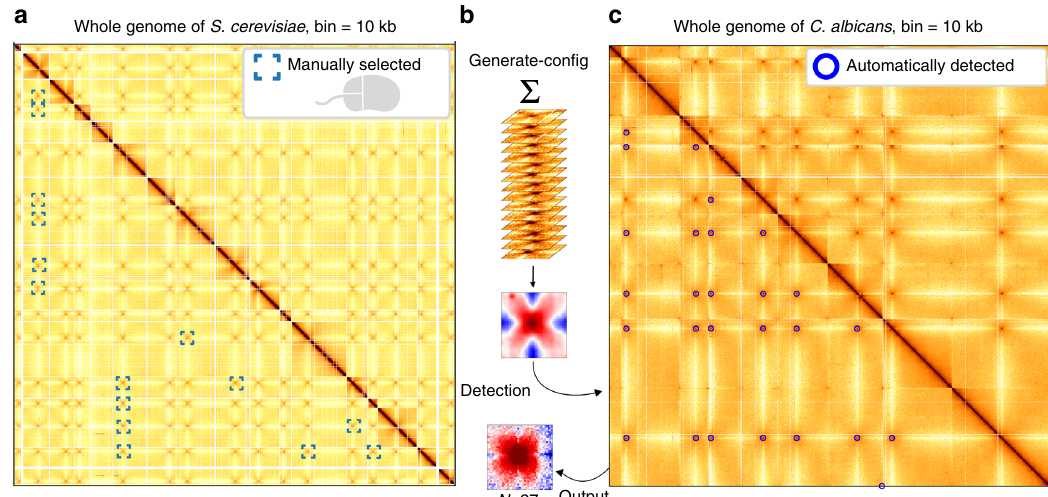
Fig. 5 Point and click mode. a Whole-genome contact map of S. cerevisiae 8 with 15 inter-centromere patterns that were selected by hand. Darker means more contacts. b Chromosight generates a new kernel by summing all the selected patterns and applying a Gaussian fi lter. c Chromosight detection of the inter-centromeres patterns in the whole-genome contact map of C. albicans 49 with the resulting pileup plot of the 27